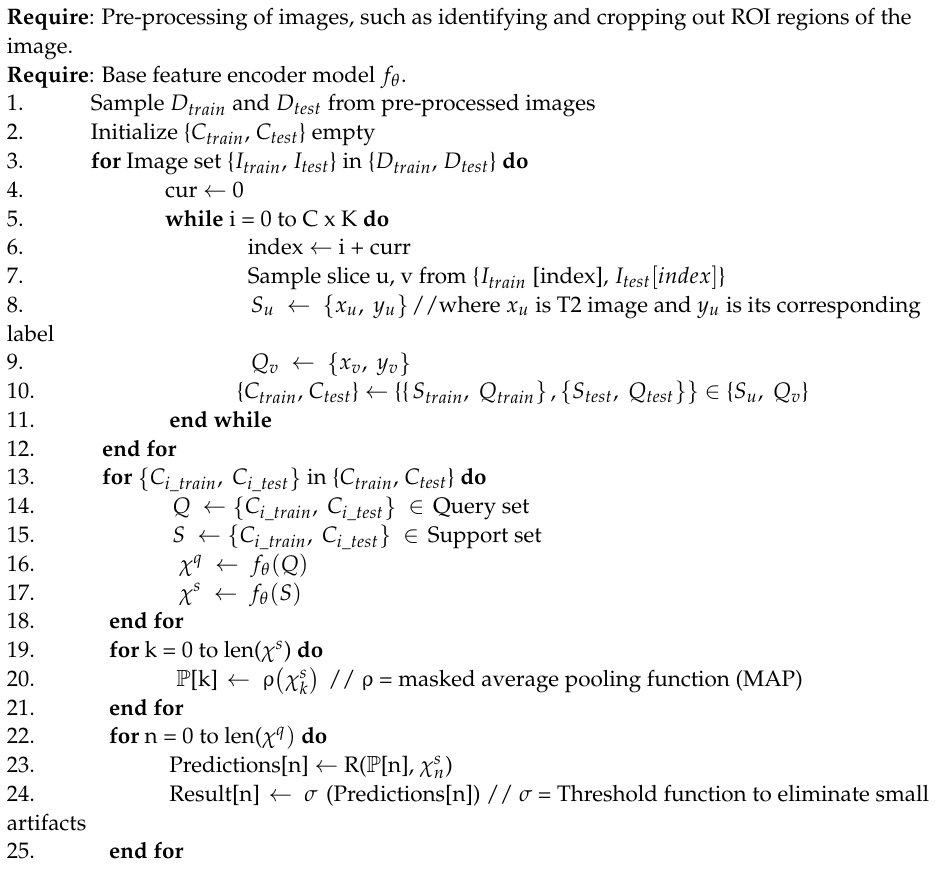
Algorithm 1. Foreground prototypes based on few-shot